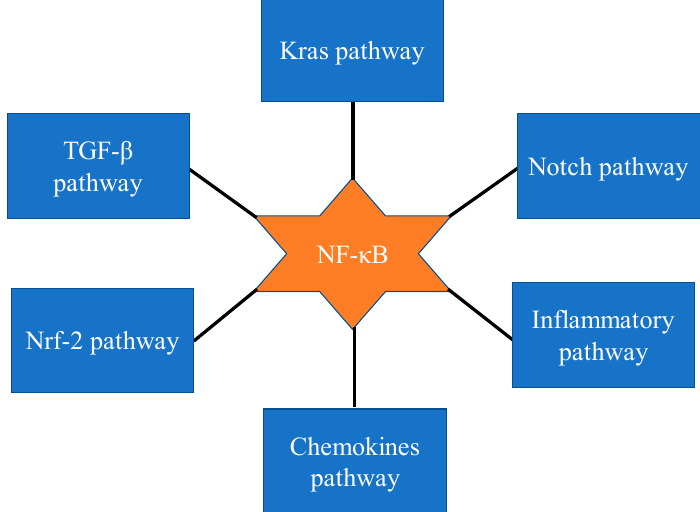
Figure 2. Cross talk of NF- κ B signaling with others signaling in pancreatic cancer.